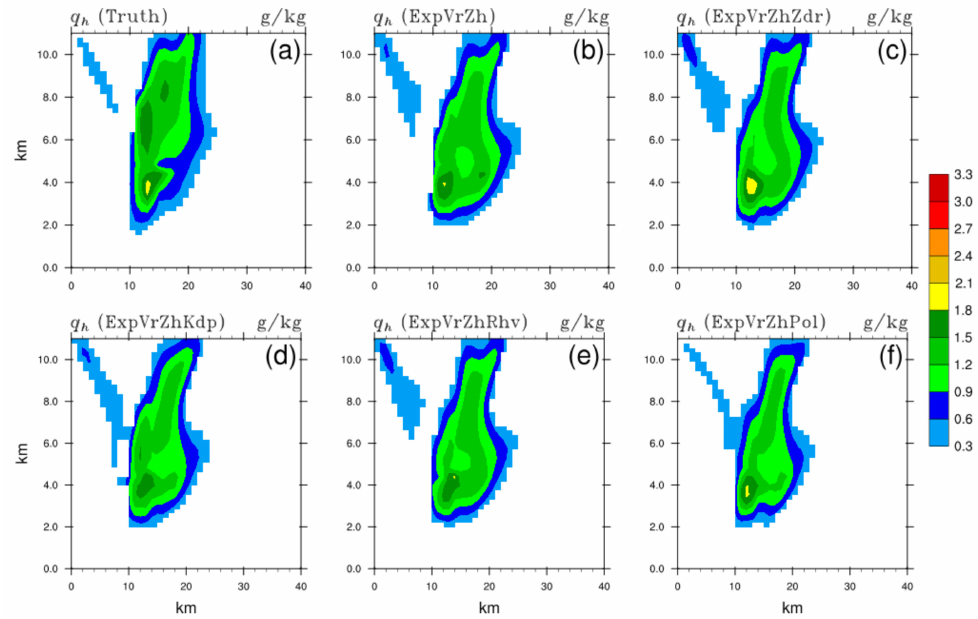
Figure 13. The same as Figure 7, but for the mixing ratio of hail q h (unit: g/kg) of ( a ) truth, and anal- ysis fields of ( b ) ExpVrZh, ( c ) ExpVrZhZdr, ( d ) ExpVrZhKdp, ( e ) ExpVrZhRhv, and ( f ) ExpVrZhPol,